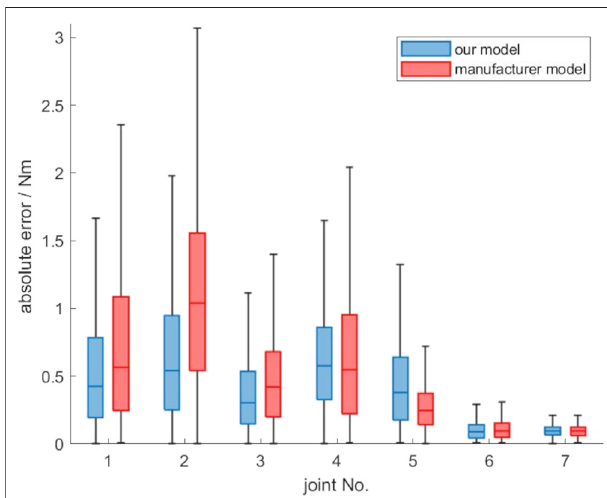
FIGURE4| Absolute erroroftheproposed gravity compensationmodel compared to the model of the robot manufacturer, evaluated on the dataset gen , dir